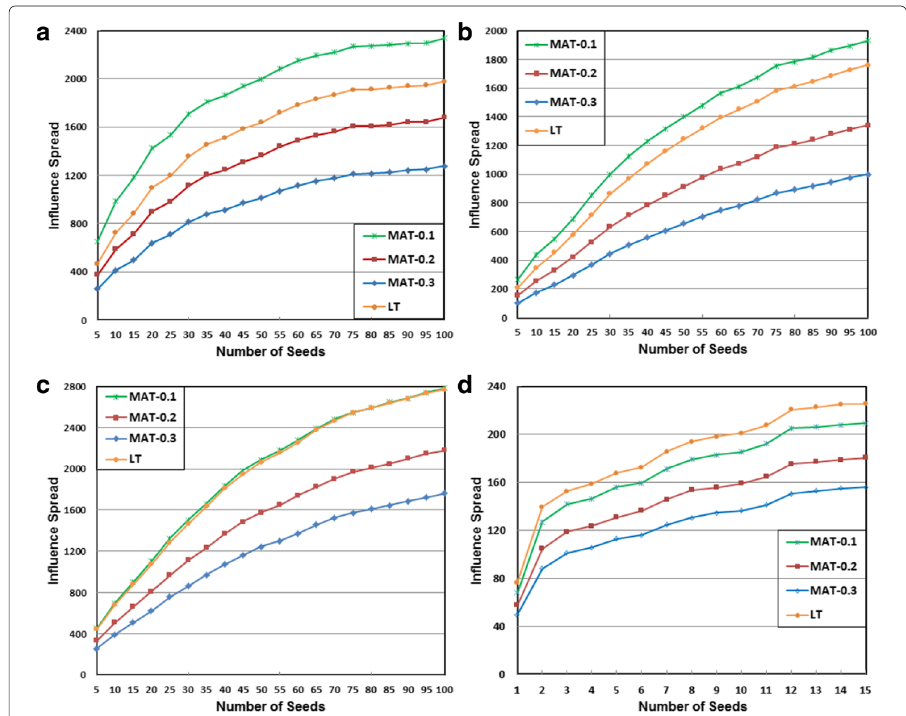
Fig. 4 Influence spread achieved by DEGREE under the classic LT model and the MAT model with different temporal influence decay rates. a PGP dataset, b NetHEPT dataset, c WikiVote dataset, and d C.elegans